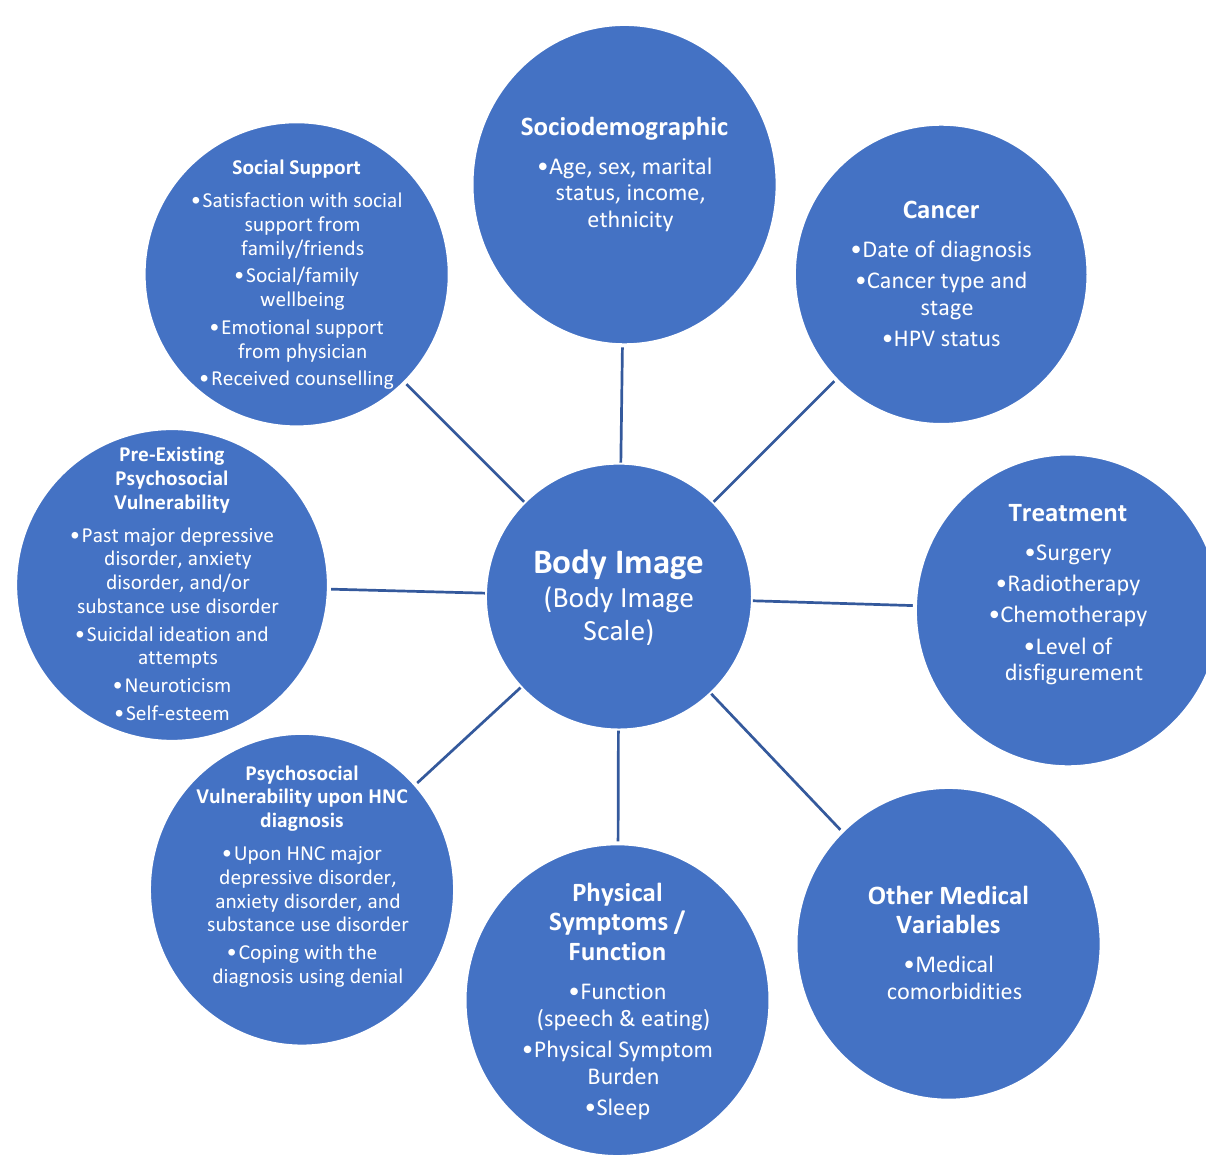
Figure 1. Conceptual model of predictors of body image concerns in patients with HNC.